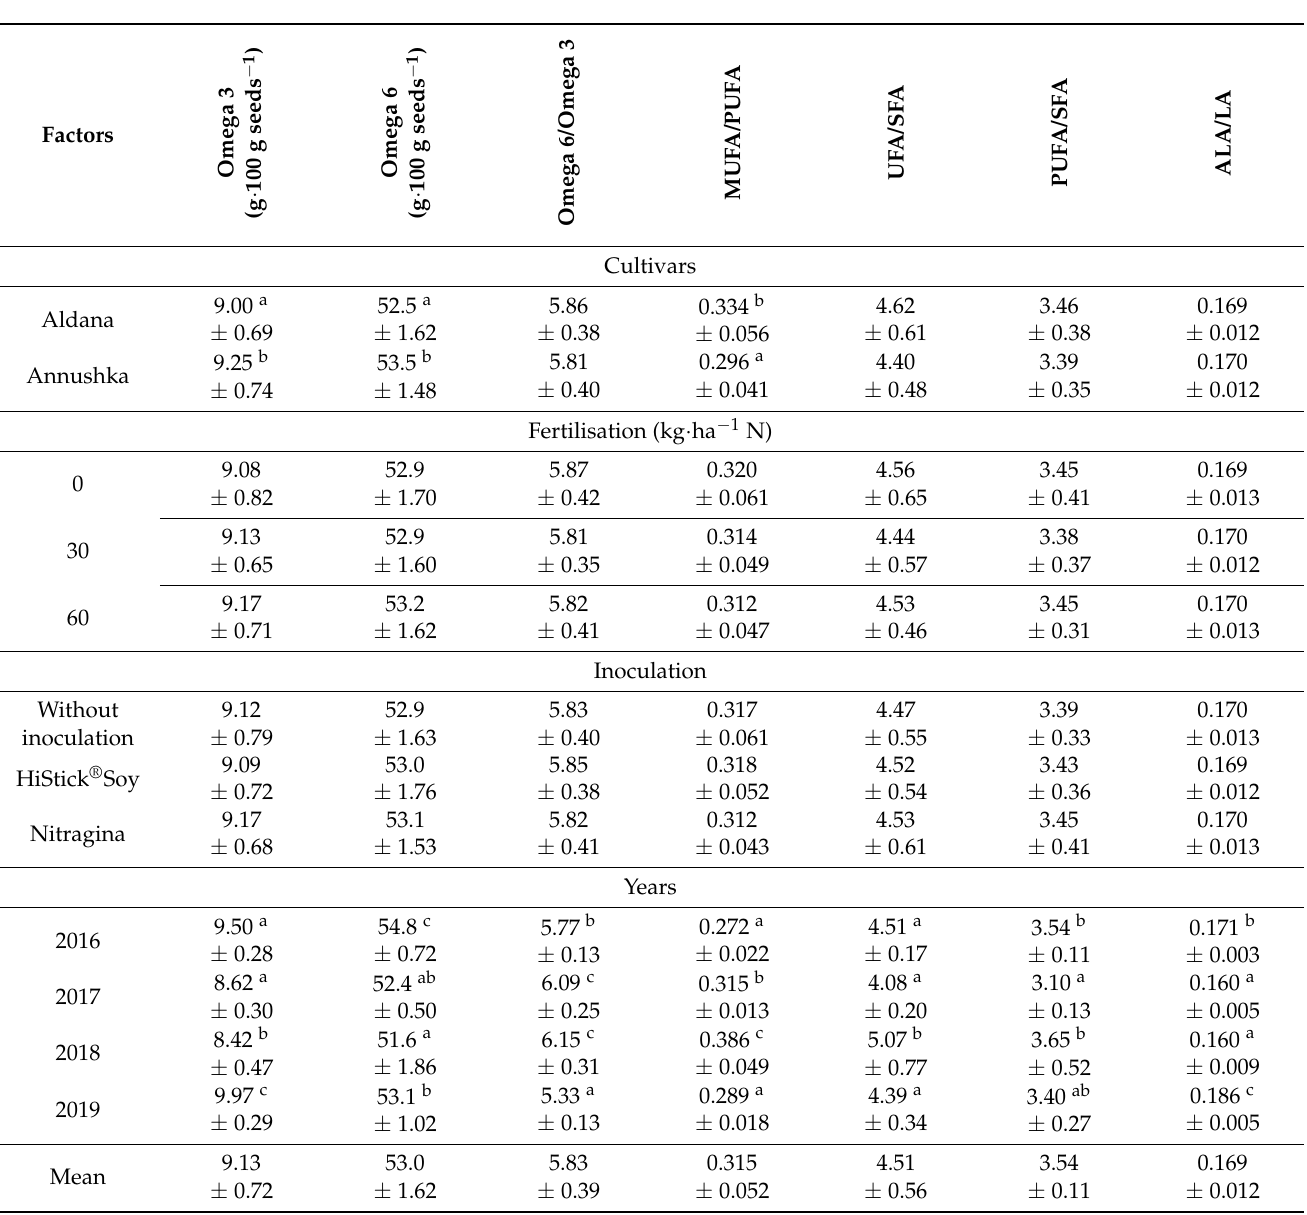
Table 3. The content of Omega 3 and Omega 6 (g FA 100 g seeds − 1 ) as well as the ratio of Omega 6/Omega 3, MUFA/PUFA, PUFA/SFA, UFA/SFA and ALA/LA in G. max seeds; mean